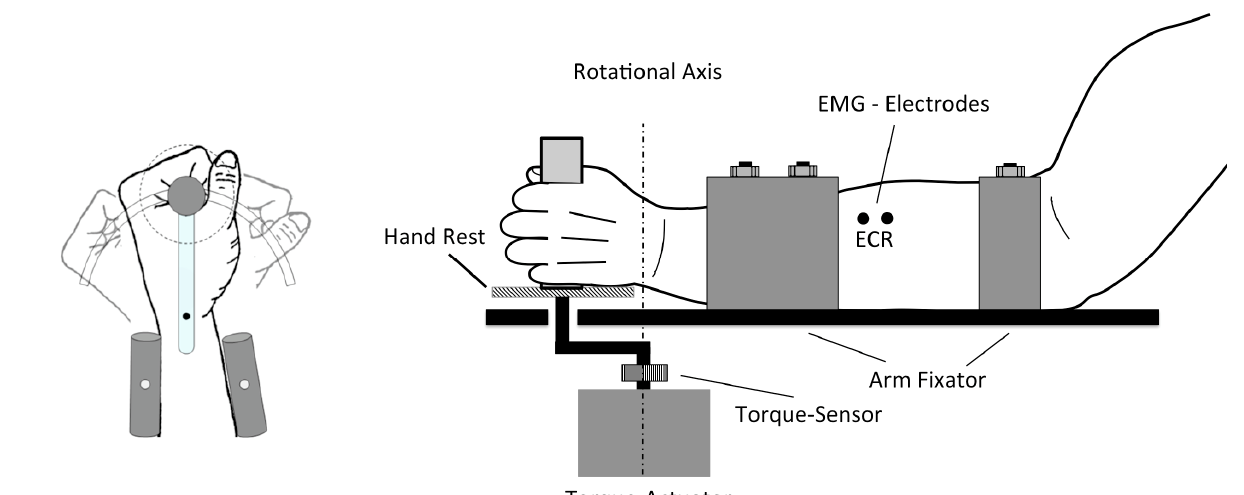
Figure 4. The graphical representation of the flexion-extension machine for wrist movement shows a rotary motor driven lever, a hand rest (dotted circle on the right) and a forearm rest, and the moving hand grip. Electrodes were placed over the extensor carpi radialis (ECR).